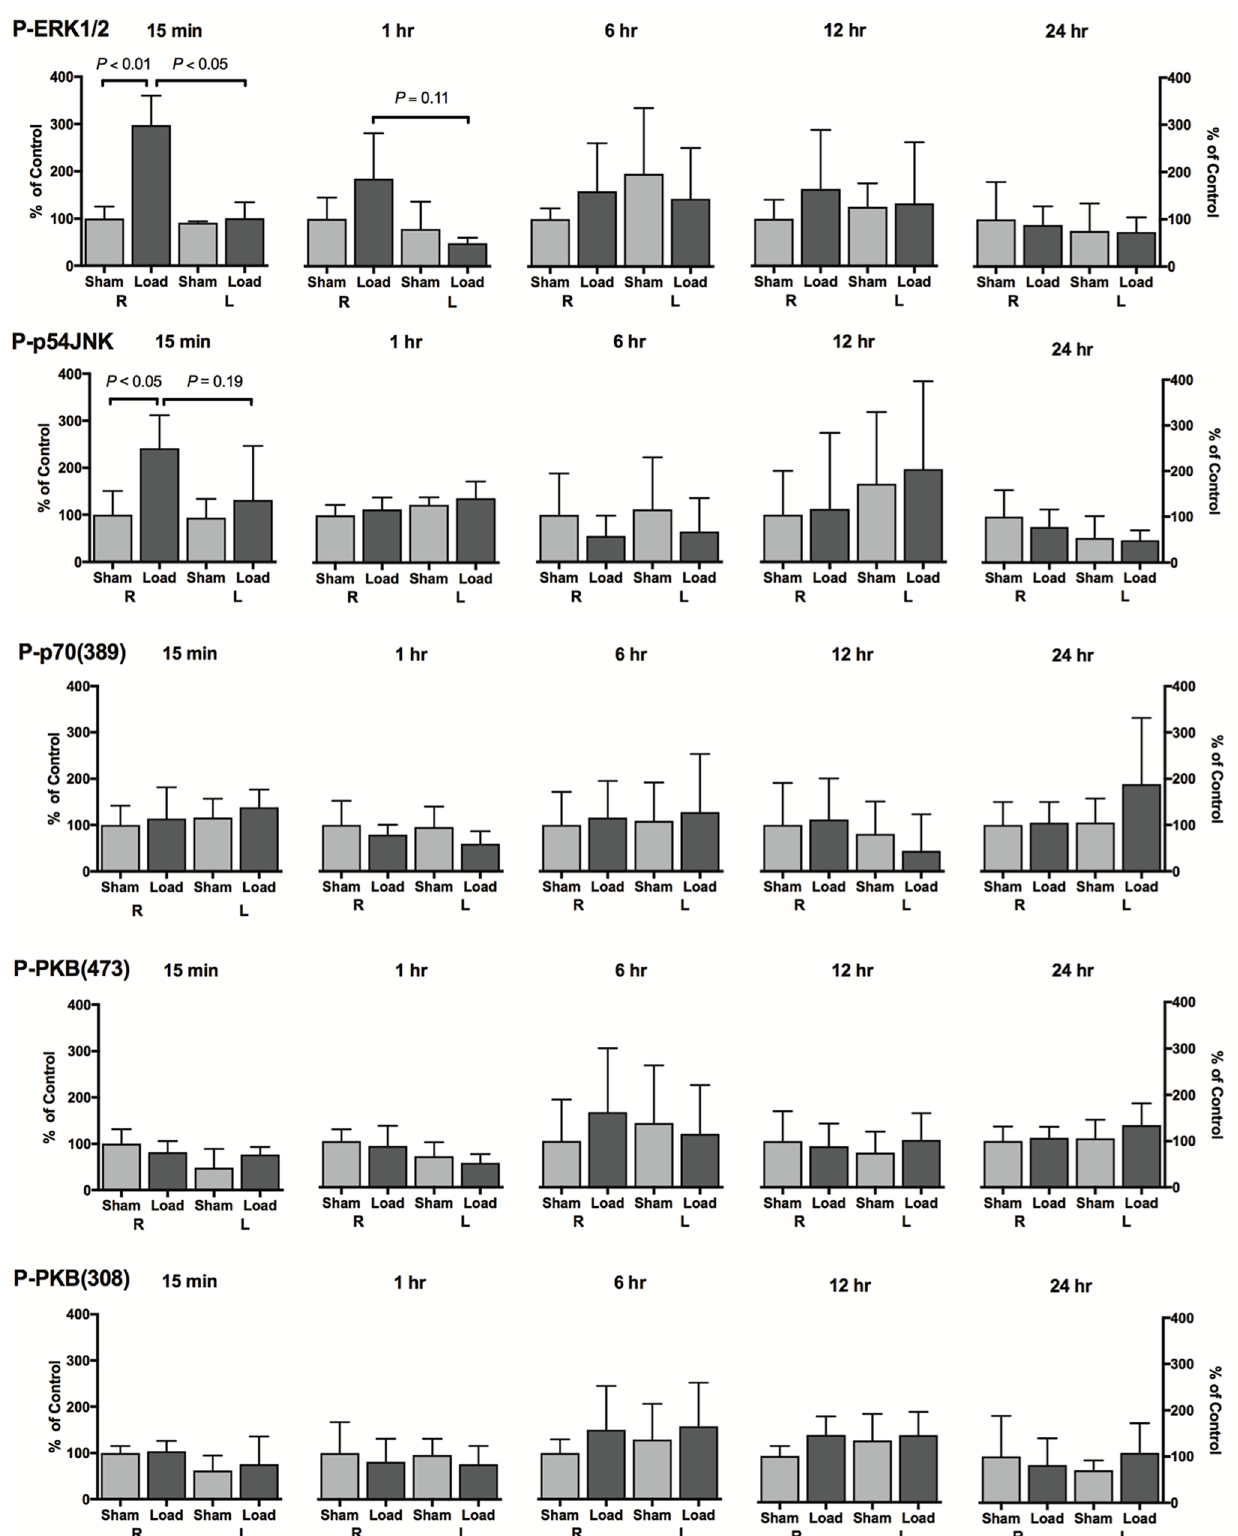
Fig 3. Signaling events in bone after a single period of mechanical loading. A cyclic compressive load was applied to the right antebrachium for 1,500 cycles at a peak strain of −3750μ ε using a haversine waveform at 4Hz and a peak load of −18.0N. Significant increases were noted in phosphorylation of ERK and p54JNK in the right loaded ulnae compared to sham controls as measuredby Western blot analysis. All data is expressed as a percentage of the right sham control limb. https://doi.org/10.1371/journal.pone.0192760.g003 PLOS ONE | https://doi.org/10.1371/journal.pone.0192760 February 27,